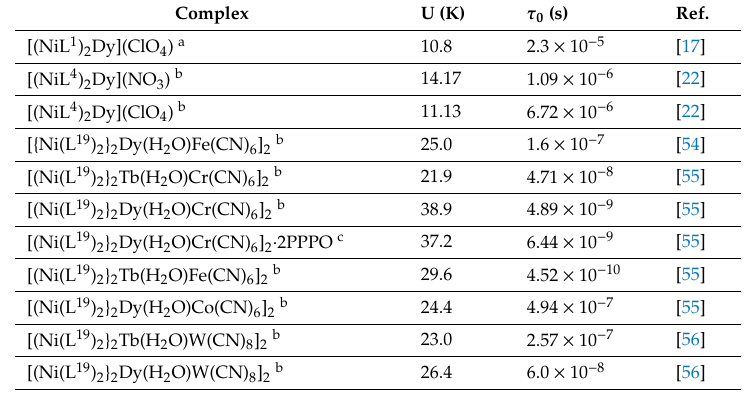
Table 3. Complexes containing the Ni II -Ln III -Ln II moiety that behave as Single-Molecule Magnets (SMMs). Complex U (K) τ 0